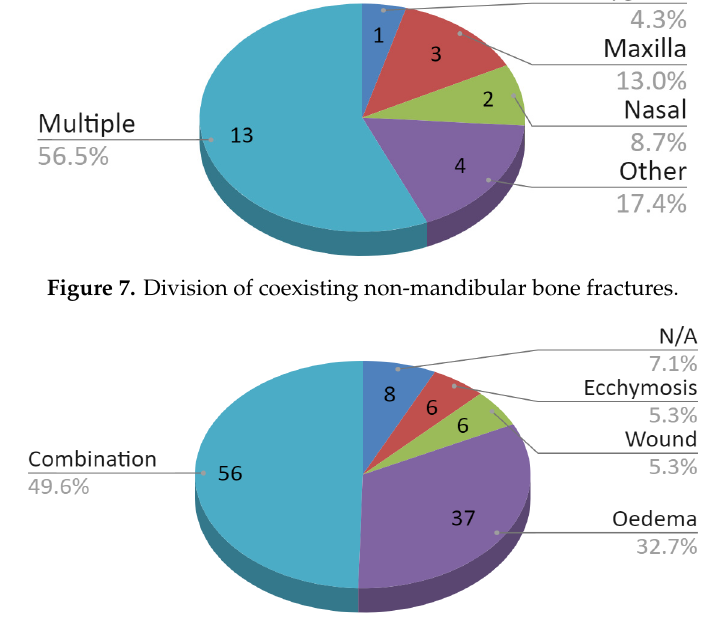
Figure 8. Coexisting soft tissue injuries.